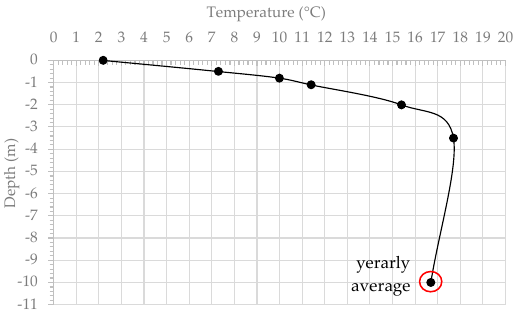
Figure 7. Initial vertical distribution of undisturbed ground temperature (TekneHub Laboratory, 1 January 2015).